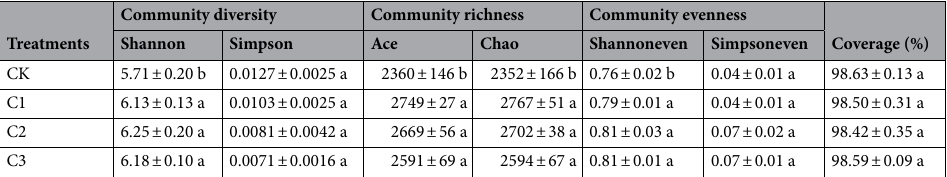
Table 3. Soil bacterial diversity parameters under different compound ratios of soft rock:sand. CK, the volume ratio of soft rock to sand is 0:1; C1, the volume ratio of soft rock to sand is 1:5; C2, the volume ratio of soft rock to sand is 1:2; C3, the volume ratio of soft rock to sand is 1:1.